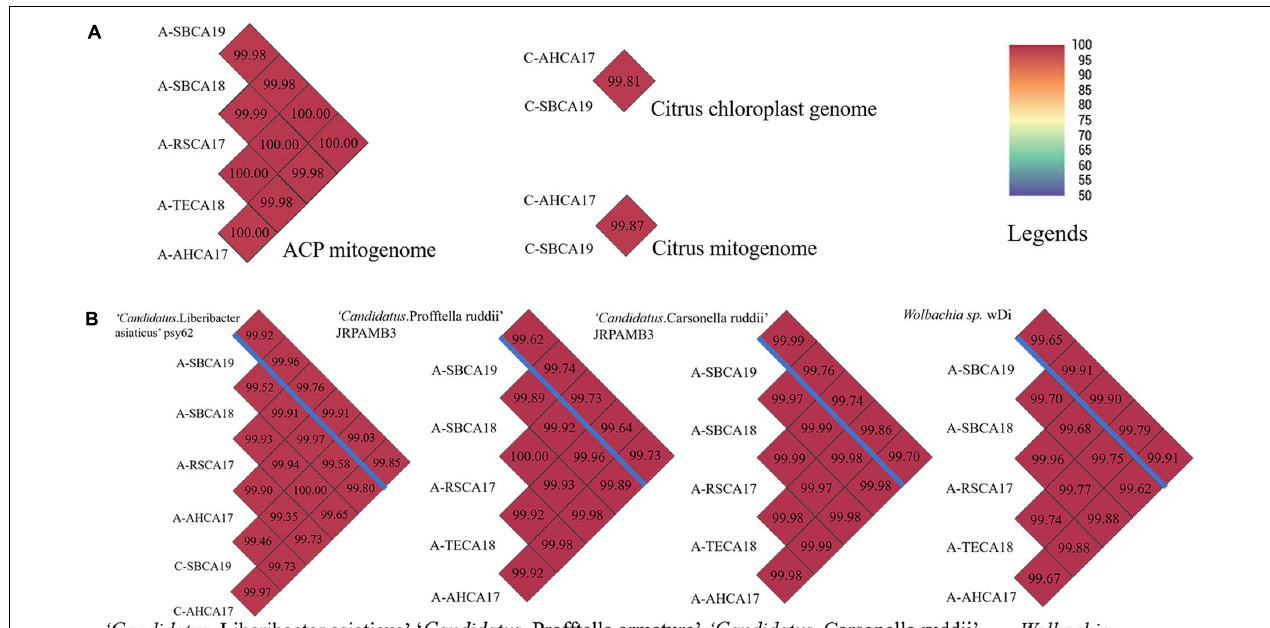
FIGURE 3 | Pairwise average nucleotide identity (ANI) comparisons of (A) mitogenomes of ACP samples and mitogenome and chloroplast genome of citrus samples and (B) draft genomes of “ Candidatus Liberibacter asiaticus,” “ Candidatus Profftella armature,” “ Candidatus Carsonella ruddii,” and Wolbachia , from ACP and citrus samples from southern California. Draft genome sizes were listed in Supplementary Tables 1 , 2 . (B) Reference genomes were listed above the blue bar. ANI values were also coded in color as explained in the legends. ANI was calculated based on fragment size of 500 bp.